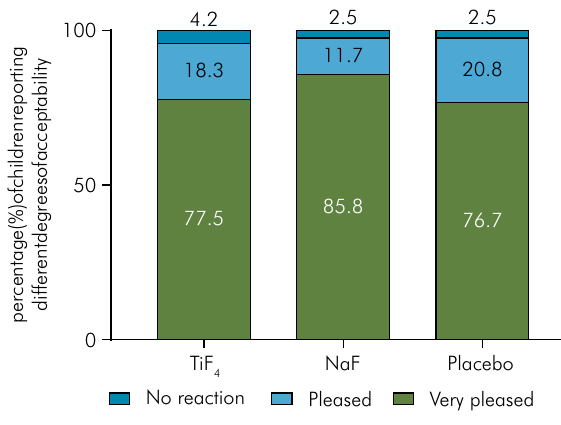
Figure 3. Mean percentage of children reporting different degrees of acceptability at the end of the six applications of the varnish using a visual scale. No child scored > 4. χ 2 results showed no association between the type of treatment and the degree of acceptability (p = 0.515, n = 20